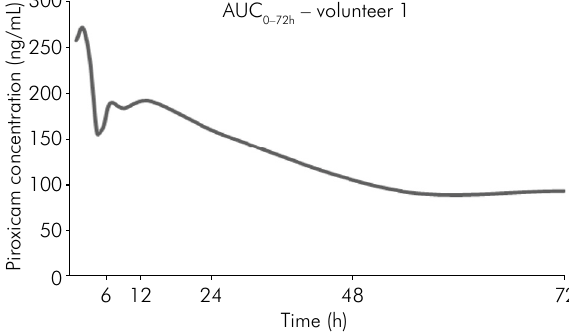
Figure 2. Area under the concentration versus time curve (AUC ) of piroxicam (0 to 72 h) from a representative 0–72h volunteer (volunteer 1).